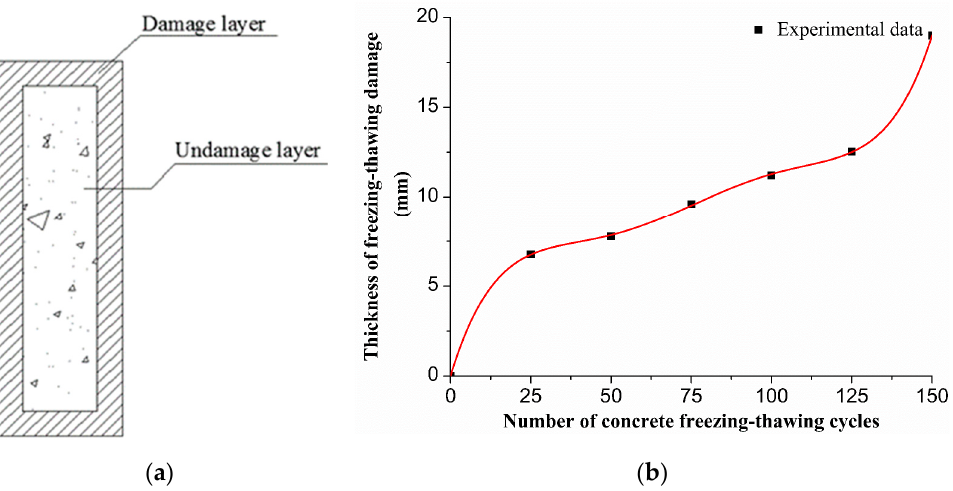
Figure 2. ( a ) Damaged layer distribution of freezing–thawing concrete section and ( b ) the curve of relationship between the number of freezing–thawing cycles and damage relationship between the number of freezing–thawing cycles and damage thickness.